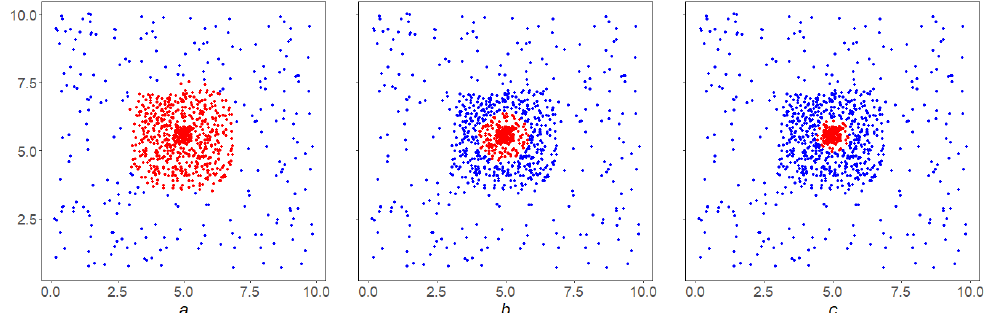
Figure 9. Illustration from left to right of the quality of the SDPS algorithm at β = − 0.3; 0.1; 0.3. Clustering in figure ( a ) is clearly better, and in figures ( b , c ) is approximately the same. (As a fuzzy comparison, we used n ( a , b ) = ( b − a ) / ( b + 1 )